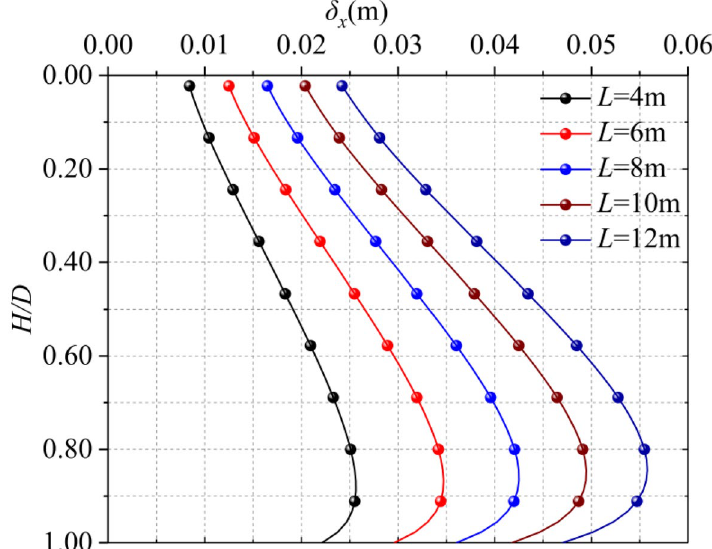
Figure 8. Horizontal displacement of different trench lengths.